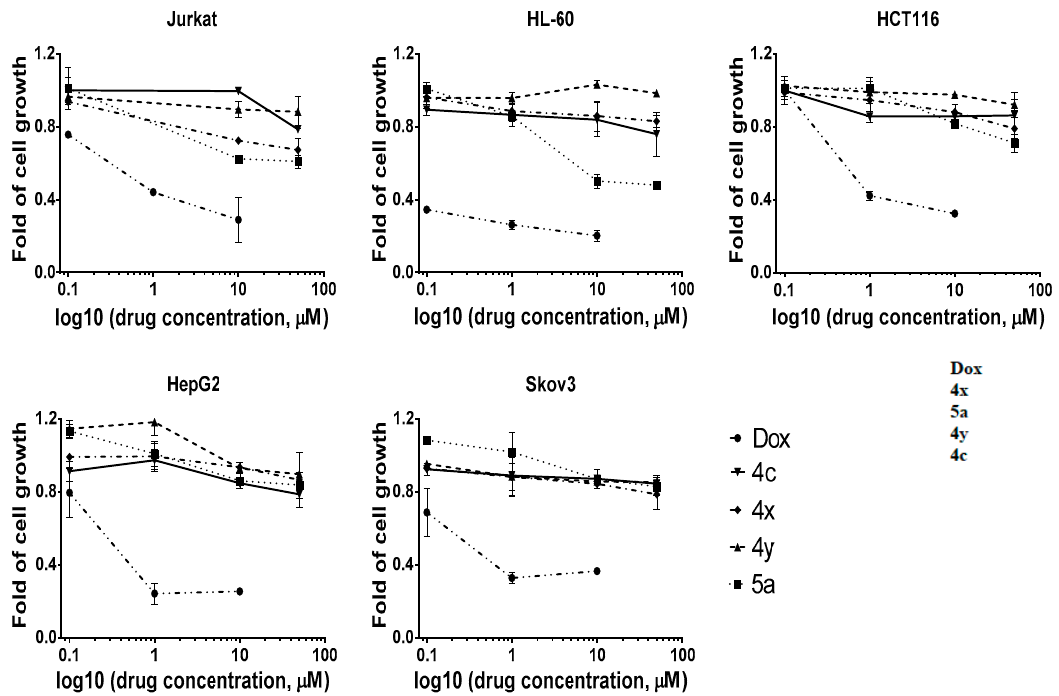
Figure 4. Cytotoxicity of thienopyrimidine derivatives towards human acute T-cell leukemia cells of Jurkat, human leukemia HL-60, human colon carcinoma HCT116, human liver HepG2 and human ovarian cancer Skov3 cell lines. After a total experimental time (72 h), cell vitality was detected by the MTT assay.